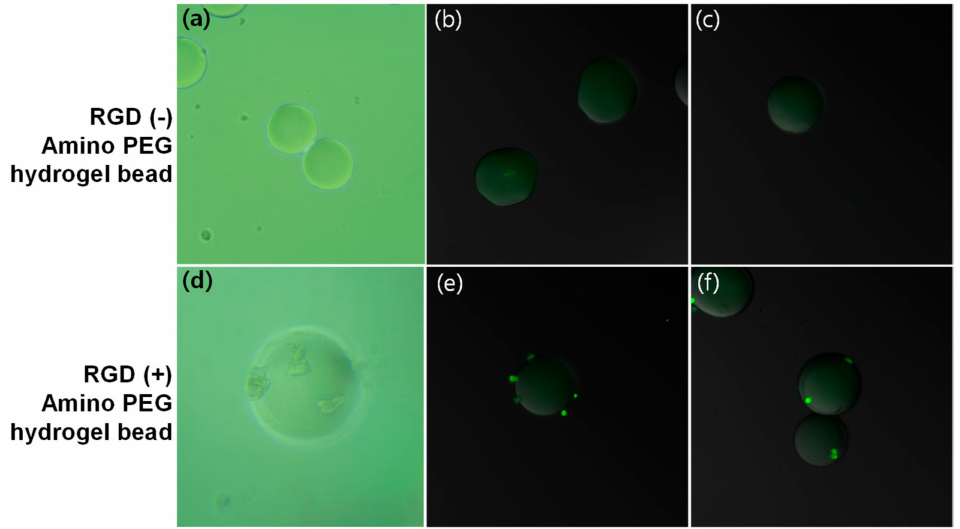
Figure 5. ( a , d ) Microscopic images and ( b , c , e , f ) confocal laser scanning microscope images of cell- treated hydrogel microbeads: NIH 3T3 cells were not attached on the PEG-amine beads (top) while cells were attached on GRGDSC peptide-immobilized PEG-amine microbeads